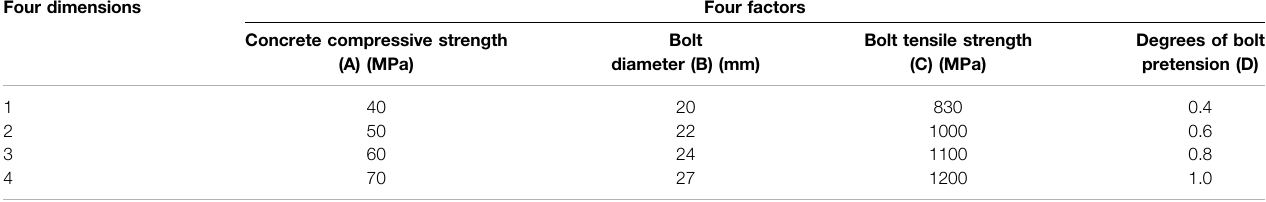
TABLE 1 | Four factors and four dimensions of orthogonal design.